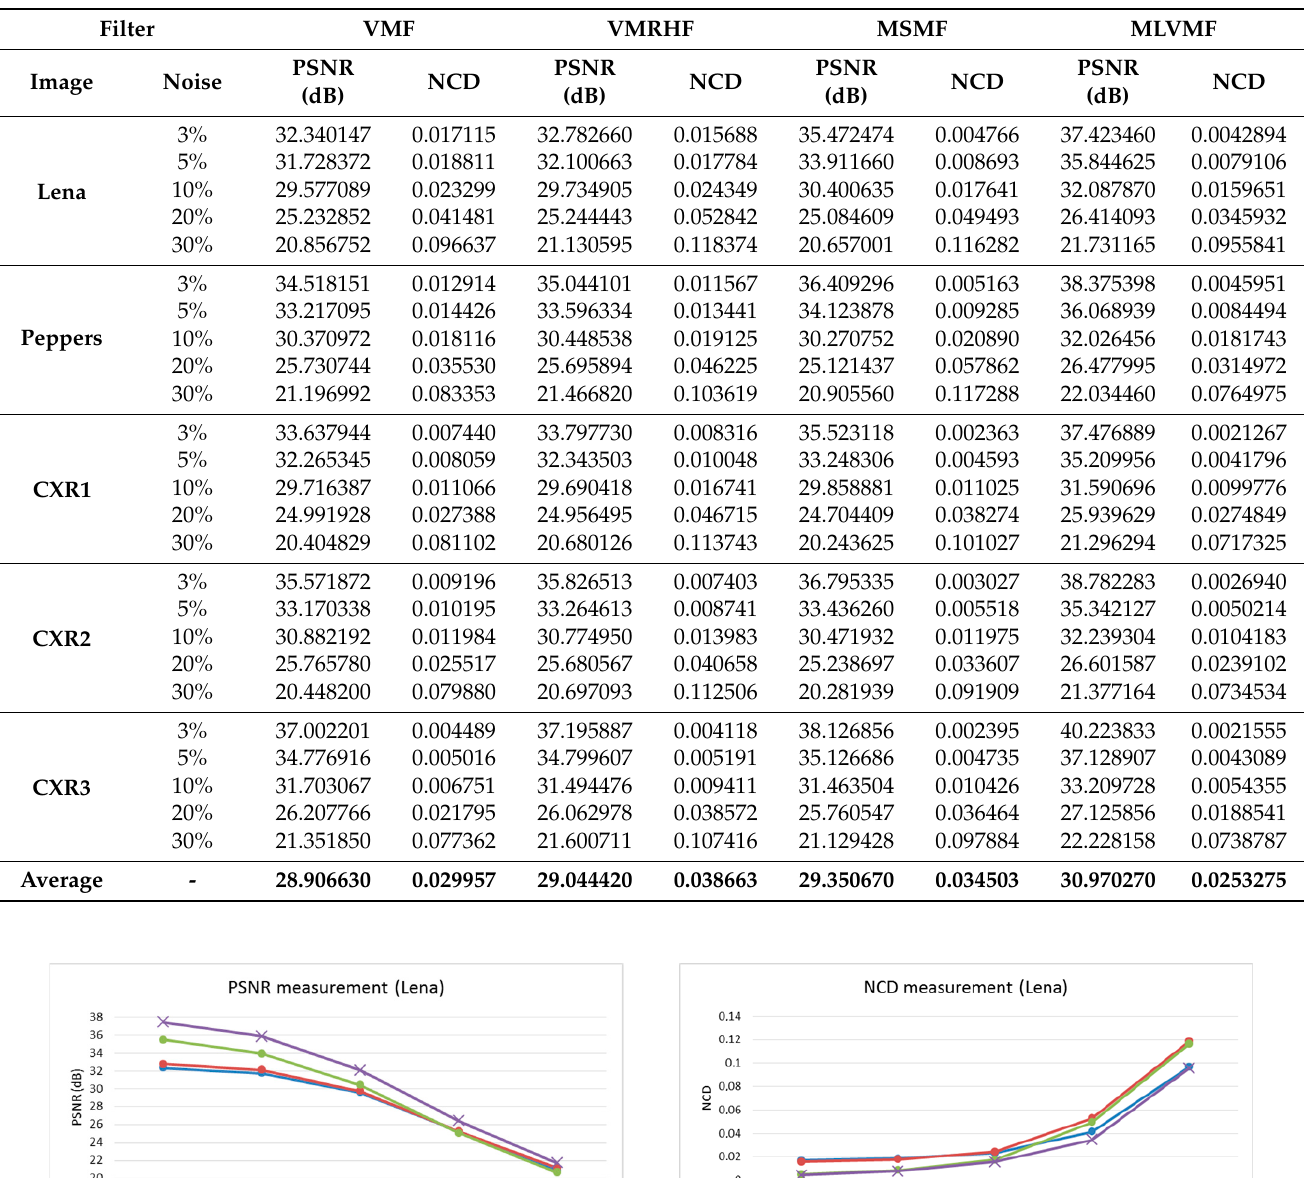
Table 1. PSNR and NCD values of the VMF, VMRHF, MSMF, and MLVMF filters for various levels of impulsive noise.